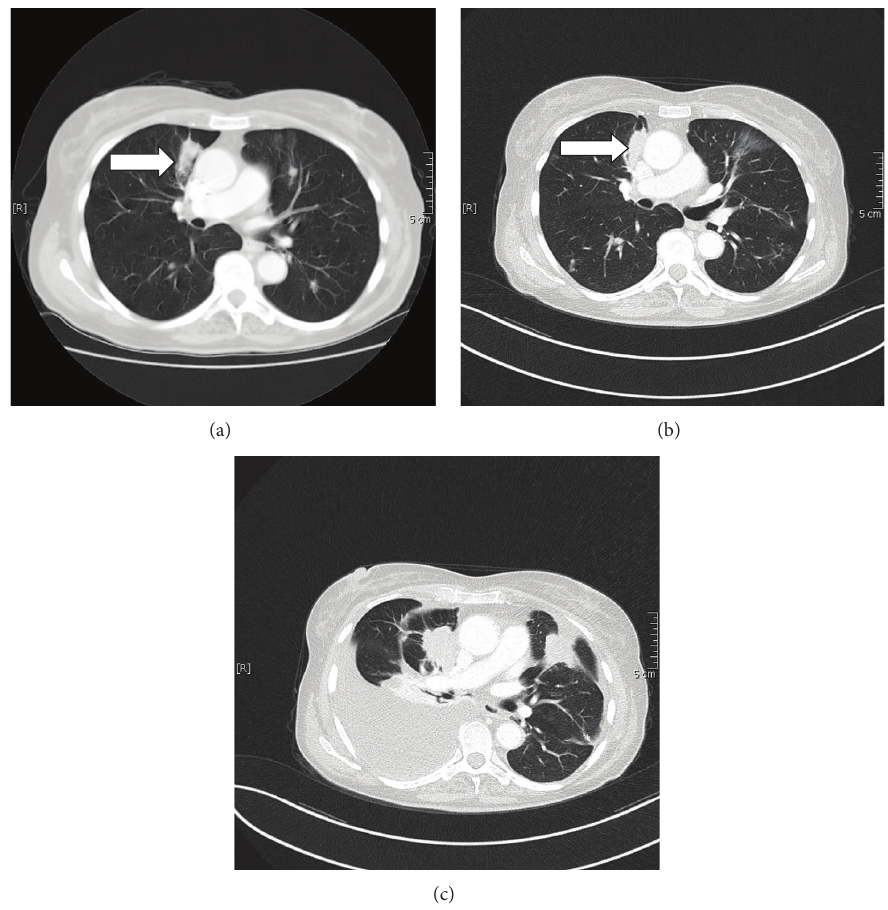
Figure 1: Contrast-enhanced tomography revealed a major pulmonary mass within the right upper lobe (arrow) (a). Stable disease was achieved under first line therapy with carboplatin and pemetrexed (b). CT-evaluation revealed tumor progression of the pulmonary mass and metastases, huge pleural effusion due to pleural carcinosis of the right side (c).